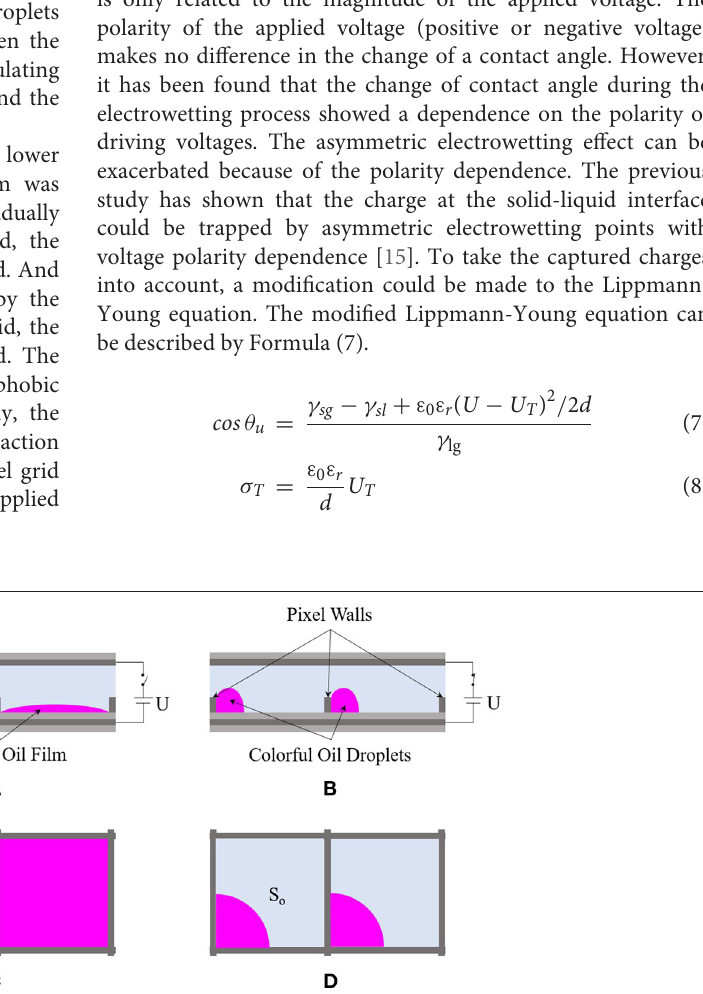
Frontiers in Physics |